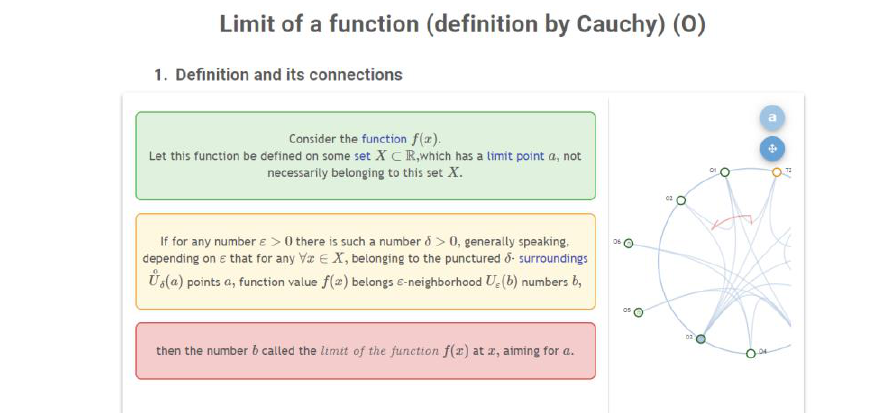
Fig. 2. The structure of a statement adopted in the DLS